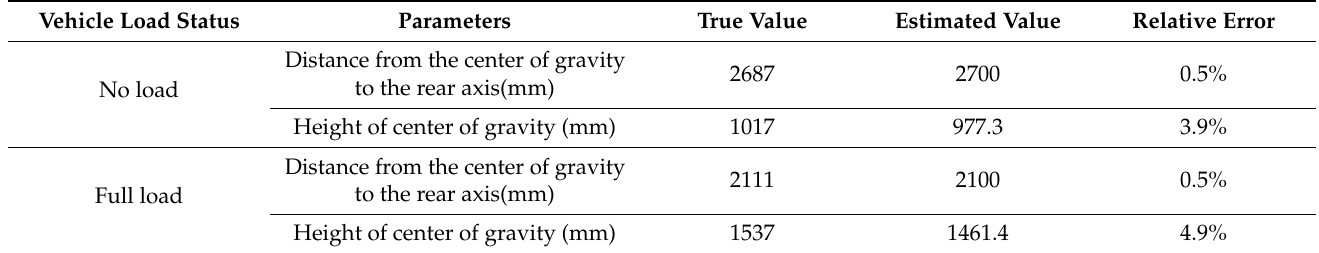
Table 4. Summary of results of center of gravity position estimation. Figure 8. Estimation results of the center of gravity position of the vehicle at full load. ( a ) Distance from the center of gravity position to the rear axis; ( b ) height of the center of gravity.